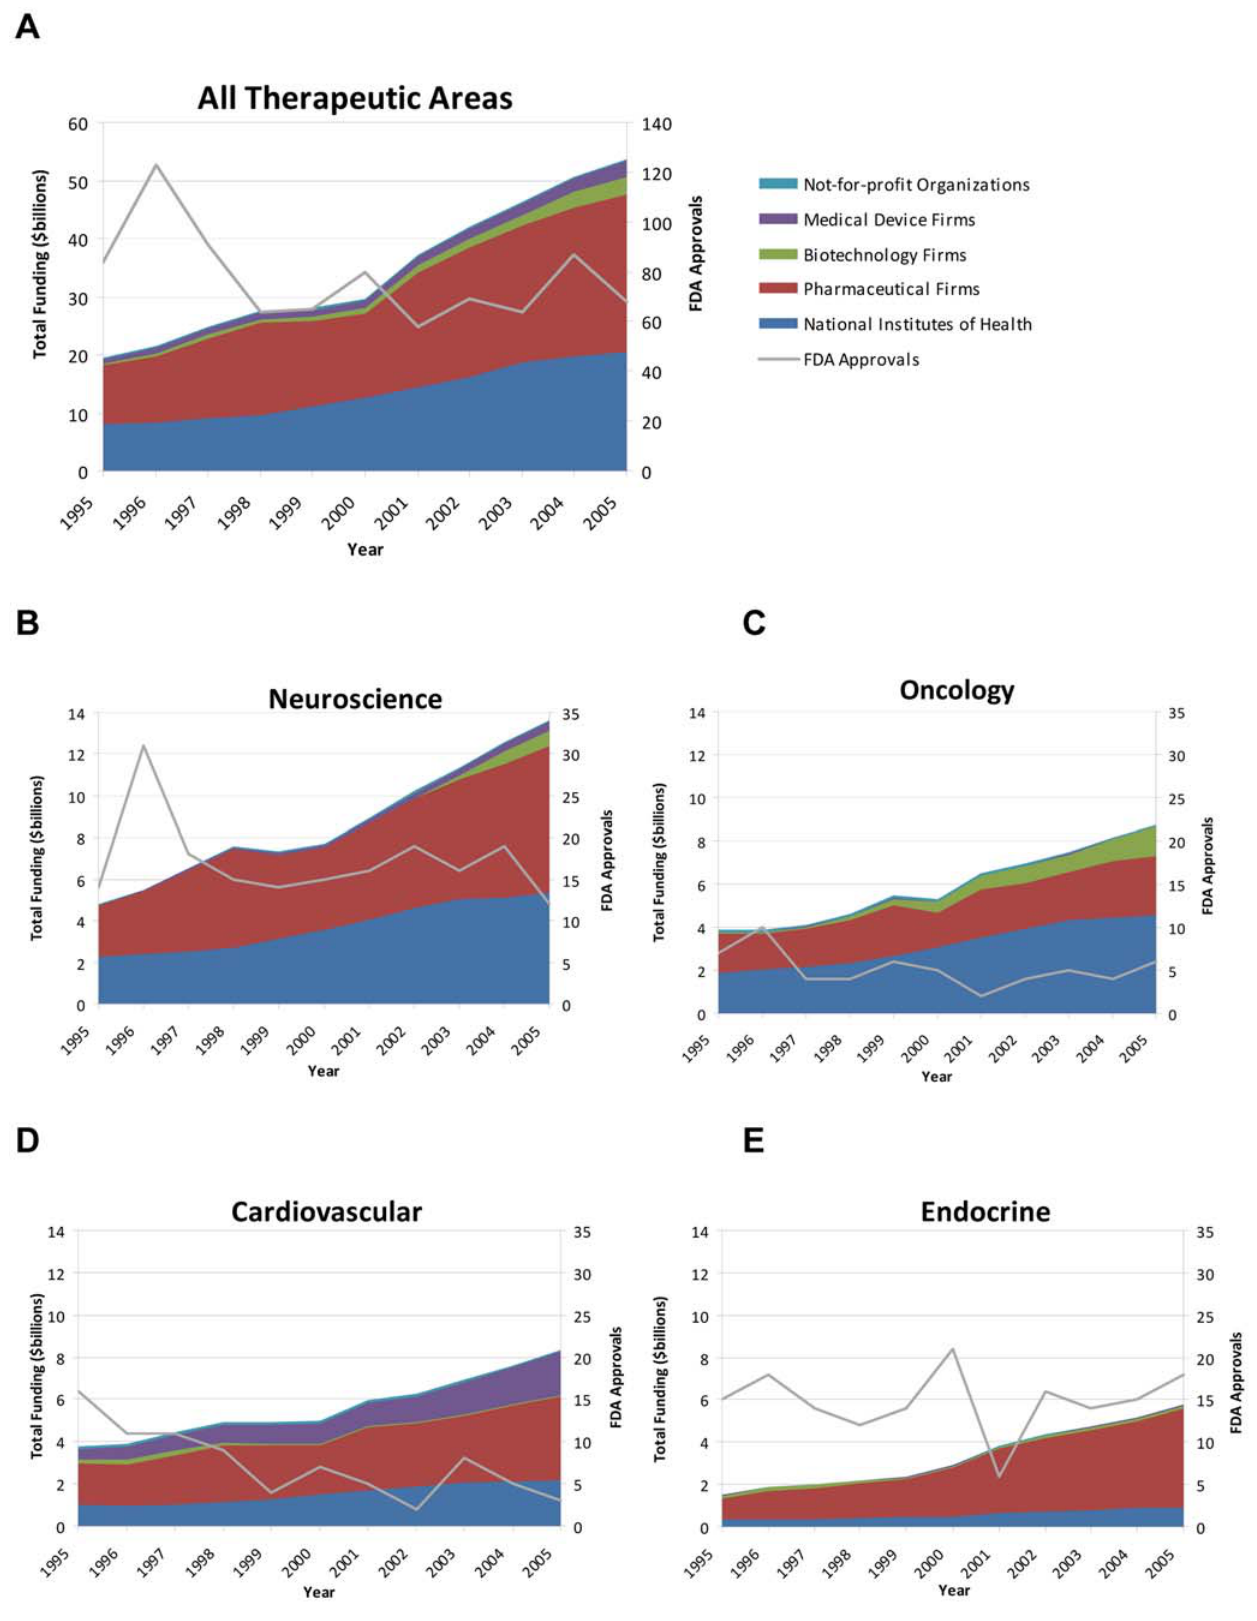
Figure 1. Research support, sponsors, and FDA new drug approvals from 1995 – 2005 for a) all therapeutic areas, b) neuroscience research, c) oncology research, d) cardiovascular research, and e) endocrine research.